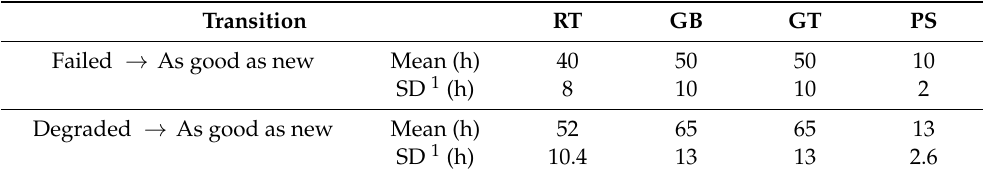
Table 6. Corrective maintenance data (replacement phase) by